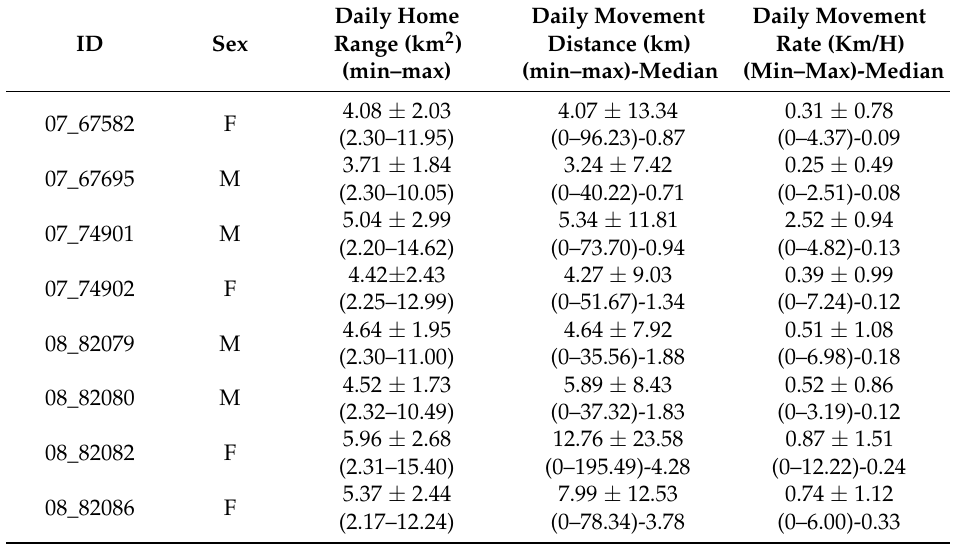
Table 3. Mean (±SD) daily home range, mean (±SD) and median daily movement distance, and mean (±SD) and median daily movement rate of Bar-headed Geese ( Anser indicus ) captured in 2007 and 2008 at Qinghai Lake.